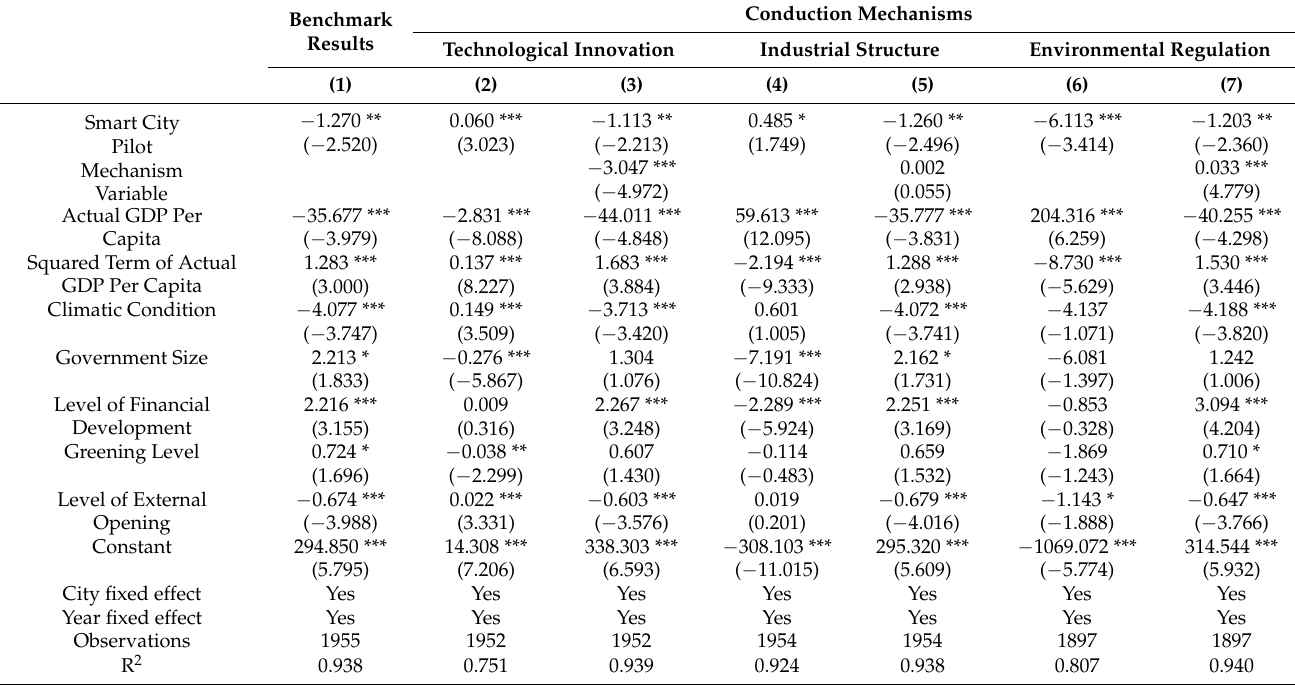
Table 5. Test results of mechanism